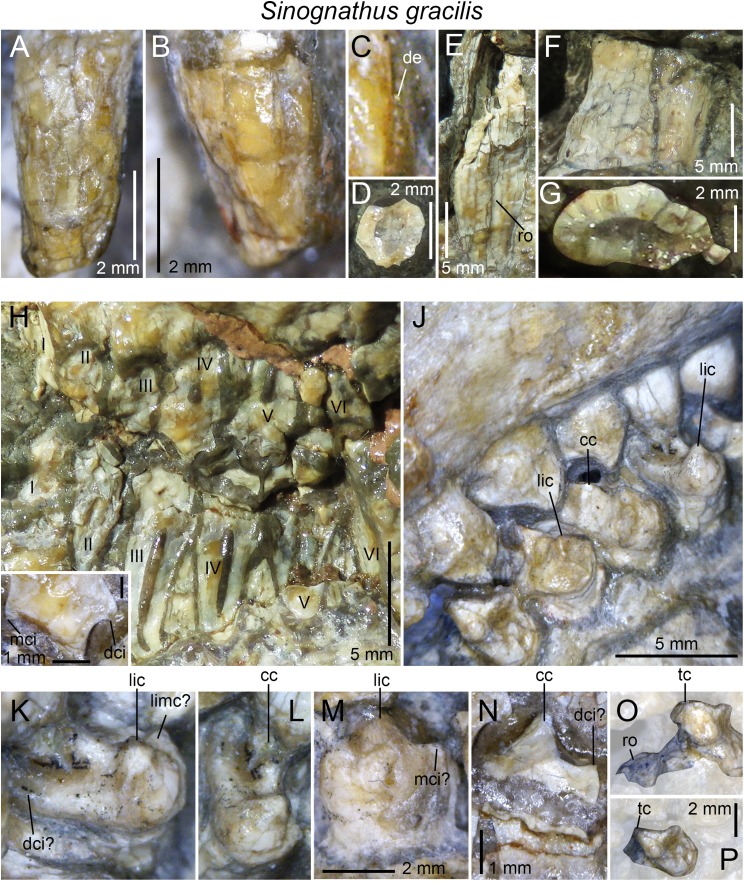
Dentition of Sinognathus gracilis (IVPP V2339).(A) Second left upper incisor in labial view; (B) fourth left upper incisor, with (C) close up on basodistal denticles, in labial views; (D) basal root cross-sectional outline of the first left upper incisor in apical view; (E) left and (F) right lower canines in labial view, with (G) close up on the cross-sectional outline through the root base of the left upper canine; (H) first to sixth upper and lower left gomphodont postcanines (sagittal cross-section through mid-crown), with (I) close up on the fourth upper gomphodont postcanine, in labial view; (J) right second to sixth upper (bottom) and second to seventh lower (top) gomphodont postcanines in linguodistal view (and apicodistal and basodistal views for the upper and lower gomphodont postcanines, respectively); (K and L) third right upper gomphodont postcanine in (K) apicodistal and (L) apicolingual views; (M) third right lower gomphodont postcanine in labial view; (N) fourth left lower gomphodont postcanine in labial view; (O and P) sixth (and last) upper gomphodont postcanine in (O) linguodistal and (P) apicolingual views. Abbreviations: cc, central cusp; dci, distal cingulum; de, denticle; lic, lingual cusp; limc, linguomesial accessory cusp; mci, mesial cingulum; ro, root; tc, transverse crest; I–VI, first to sixth gomphodont postcanines.